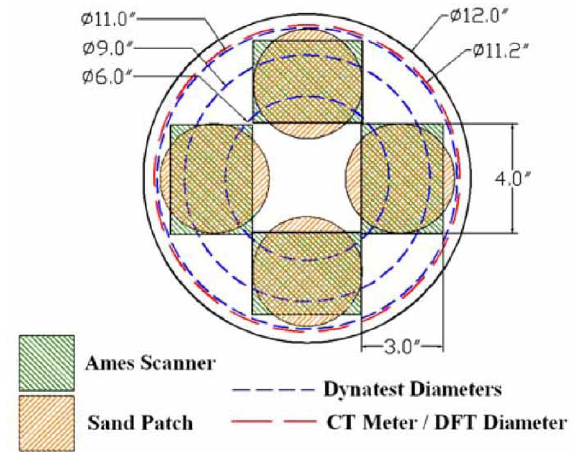
Fig. 4. Summary of areas or paths tested on each